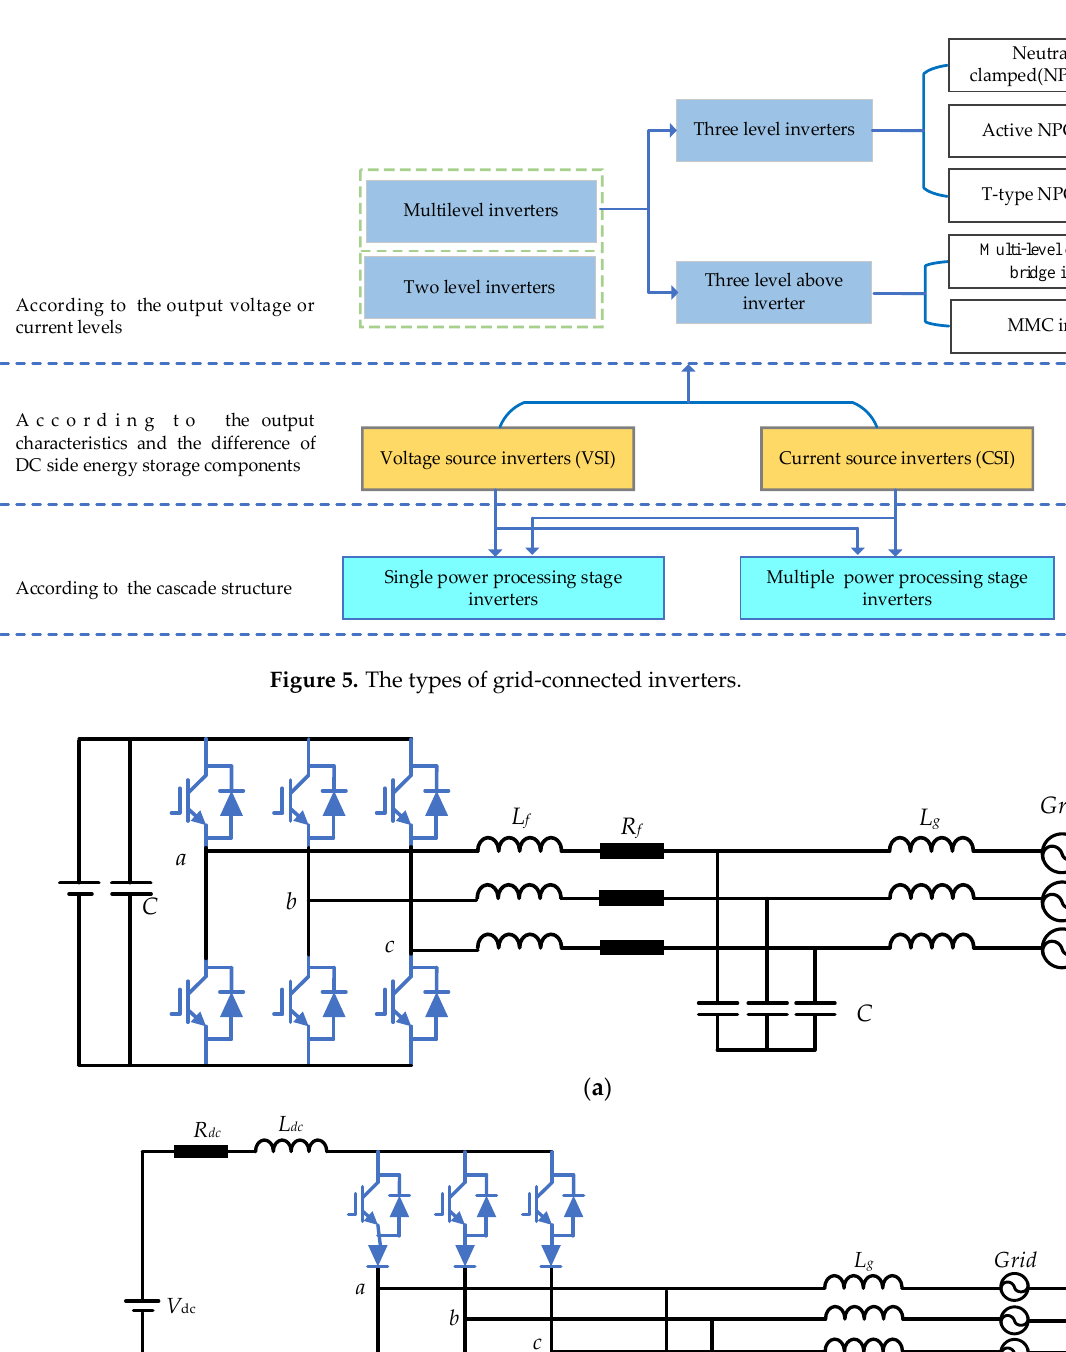
Table 2. The comparison of performance and structure between VSI and CSI.